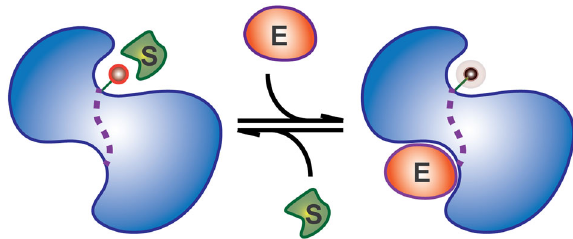
Fig. 2 Schematic diagram of dynamic allostery. An effector, E, binding to an enzyme results in increased dynamics of the active site residues, reducing the likelihood of interaction with the substrate, S, and thus reducing the enzymatic activity of the